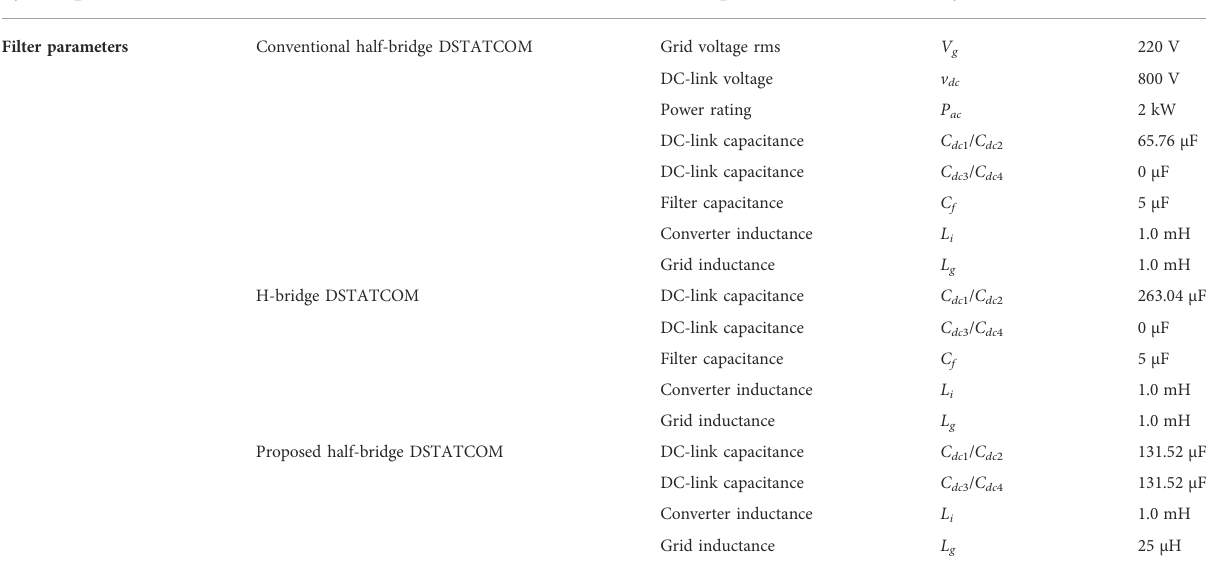
TABLE 2 Simulation parameter